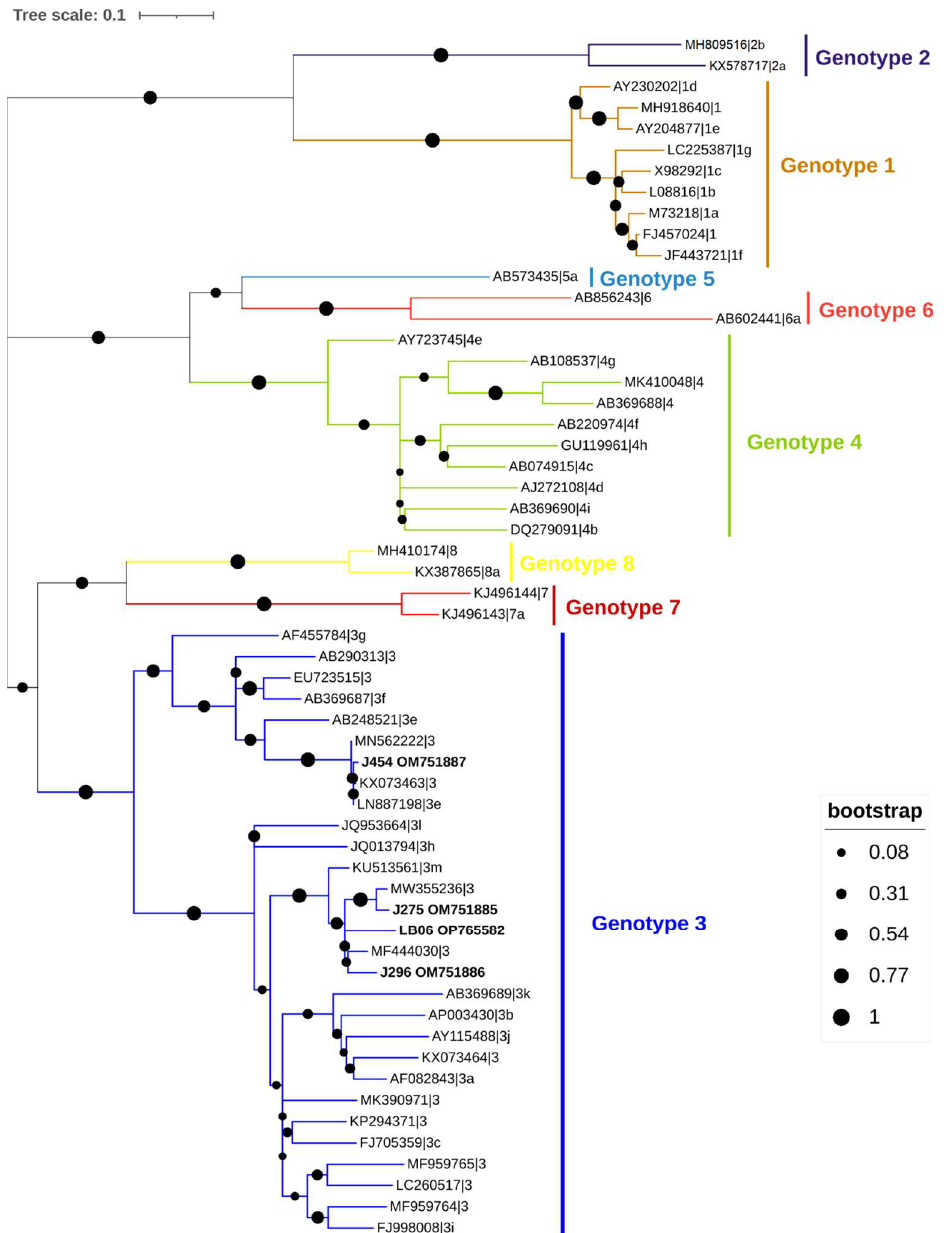
Figure 5. Phylogenetic analysis of HEV found in wild boars. Tree inferred using the MEGA X maximum likelihood method (General Time Reversible model) and the Interactive Tree of Life (iTOL) based on 57 nucleotide HEV sequences at the RNA-dependent RNA-polymerase, including sequences found in this study (HEV-3, plus its accession number, is in bold) and 53 strains of different genotypes obtained from GenBank (HEV-1 to HEV-8) (no bold or shading and identified with the accession number and its genotype and subgenotype).